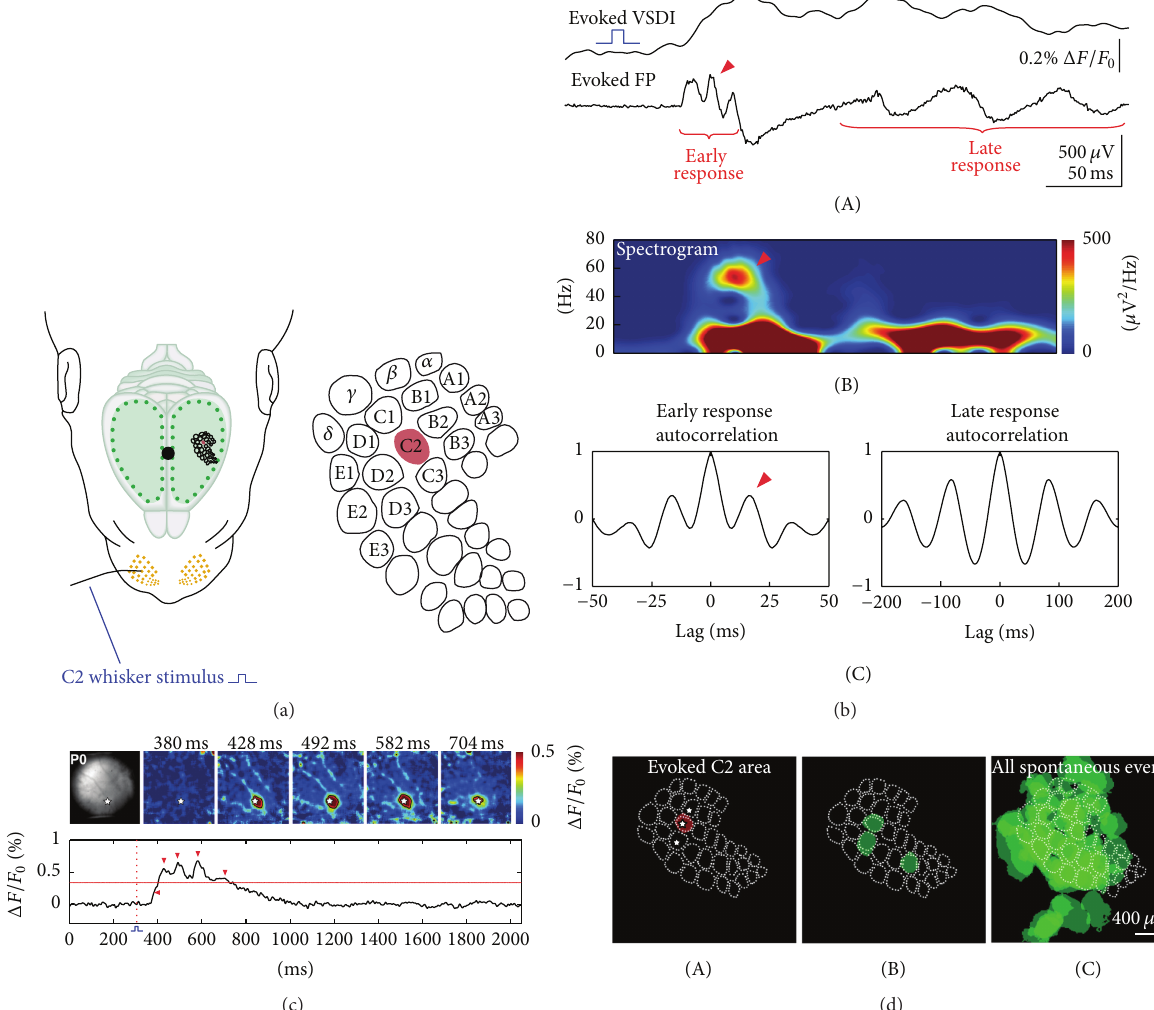
Figure 3: Stimulus-evoked (a–c) and spontaneous (d) network activity recorded in barrel cortex of newborn rats in vivo. (a) Schematic illustration of the experimental setup for selective mechanical stimulation of a single whisker (here whisker C2) (left). Black dot indicates bregma position. Schematic illustration of the barrel field with localization of the C2 barrel (red area) as revealed by stimulation of different single whiskers and monitoring the resulting VSDI response (right). (b) Cortical VSDI and simultaneous FP response to single whisker stimulation in a P1 rat. Note presence of early gamma oscillation followed by late spindle burst in the FP response (A) with typical frequency distribution in the corresponding spectrogram plot (B) and autocorrelograms (C). (c) VSDI in the barrel cortex of a P0 rat following C2 whisker stimulation at the time point of 300 ms (red-dotted line). The localization of the C2-whisker representation in the barrel cortex and 5 successive poststimulus VSDI responses are shown in the upper rows. White stars indicate the center of the C2-whisker-evoked response. Lower rows show 2s long optical recordings in which the time points of the 5 successive frames are marked by red arrow heads. Red horizontal line indicates the half-maximal response amplitude. Note that the evoked activity is restricted to the C2 barrel and does not propagate to neighbouring columns as in slightly older animals (for more information see [18]). (d) Spontaneous gamma-spindle activity synchronizes early cortical columns. Single whisker stimulation-induced VSDI response (here C2 whisker) recorded in the barrel cortex of a P1 rat (A). The barrel field map was generated on the basis of a cytochrome oxidase stained horizontal section and aligned according to the evoked VSDI responses to single whisker stimulation. White star marks the center of the activated barrel-related columns B2, C2, and D2. Three single spontaneous events localized in a single (pre-) barrel-related column (B) and overlay of all spontaneous events ((C), 𝑛 = 75 ) recorded in this P1 rat. Note complete coverage of the whole barrel field map by local spontaneous oscillations. Reproduced with permission from